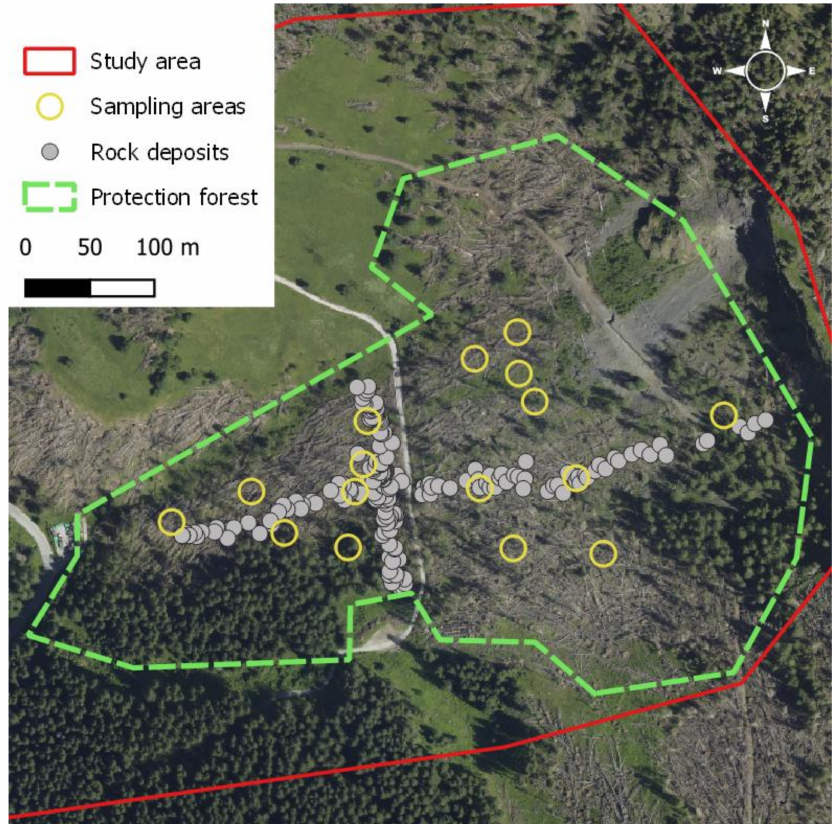
Figure 2. Localization of transects, surveyed rockfall deposits, and circular plots surveyed within the considered protection forest. High-resolution orthoimagery from aerial surveys (acquired in 2019 by Veneto